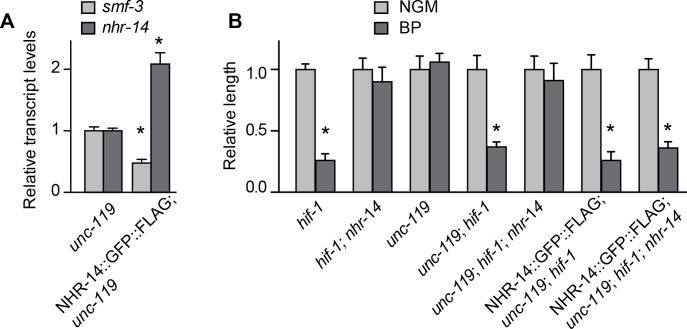
NHR-14::GFP::FLAG functions similarly to endogenous NHR-14.The functionality of NHR-14::GFP::FLAG was tested by its ability to downregulate smf-3 mRNA levels, as well as replace endogenous NHR-14. (A) smf-3 and nhr-14 mRNAs were measured by qPCR in non-injected worms (unc-119) versus NHR-14::GFP::FLAG; ttTi5606; unc-119 transgenic worms. nhr-14 mRNA levels increased and smf-3 mRNA levels decreased in NHR-14::GFP::FLAG transgenic worms compared to non-injected ttTi5606; unc-119 worms. (B) To test for functional replacement of NHR-14, mutations in hif-1 and nhr-14 were introduced into the ttTi5606; unc-119 mutant and then injected with the NHR-14::GFP::FLAG expressing fosmid. Relative worm length of strains grown under NGM (gray bars) or BP (iron chelator) (black bars) conditions was determined. Data are from at least three independent experiments with a minimum of 20 worms per strain. Values are expressed as the mean NGM length ± SEM and compared by Student's t test, *p<0.05. Note that unc-119; hif-1; nhr-14 mutants expressing NHR-14::GFP::FLAG displayed the HIF-1-dependent growth delay as compared to unc-119; hif-1; nhr-14 mutants, indicating that NHR-14::GFP::FLAG is functional.